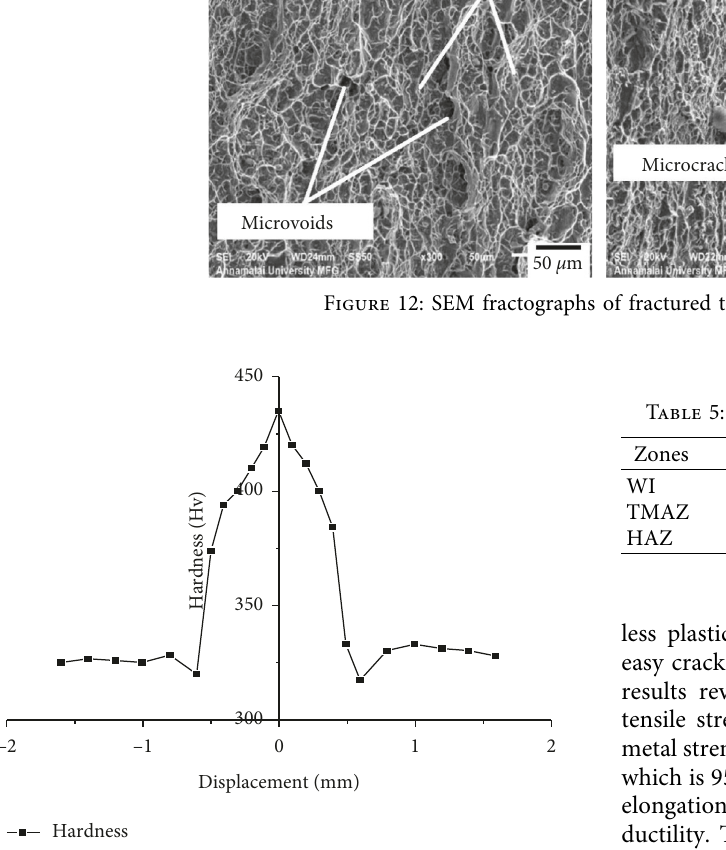
Figure 13: Microhardness distributions across the weld joint.